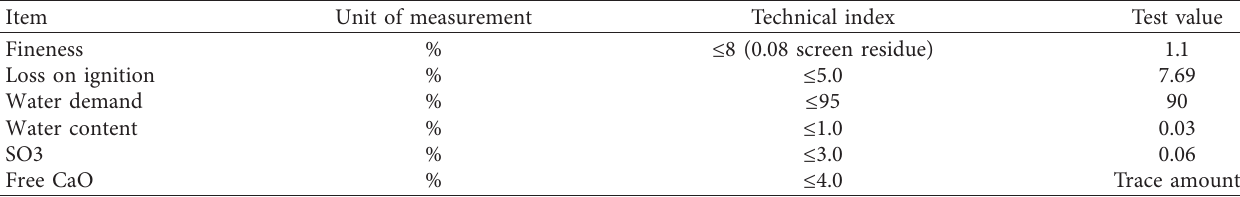
Table 2: Technical indexes of fly ash.